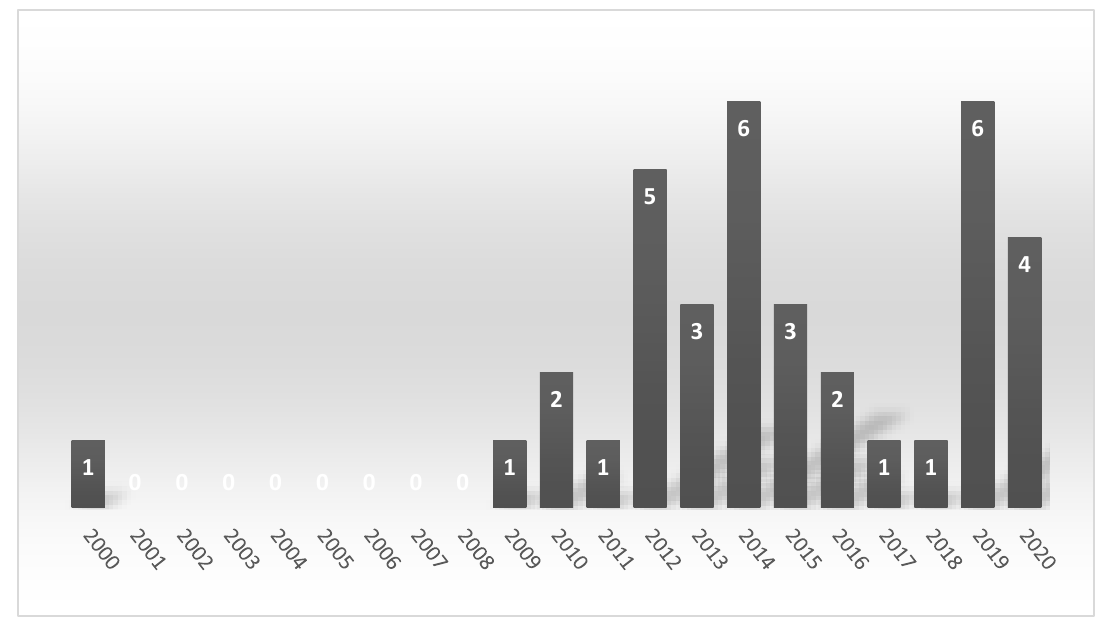
Figure 2. The number of publications regarding auditory brainstem responses (ABR) and rat model of tinnitus per year.